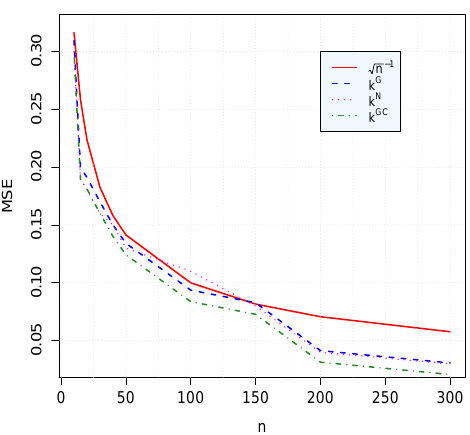
Figure 8. The MSE of ˆ k computed with Newton’s, gradient and conjugate gradient